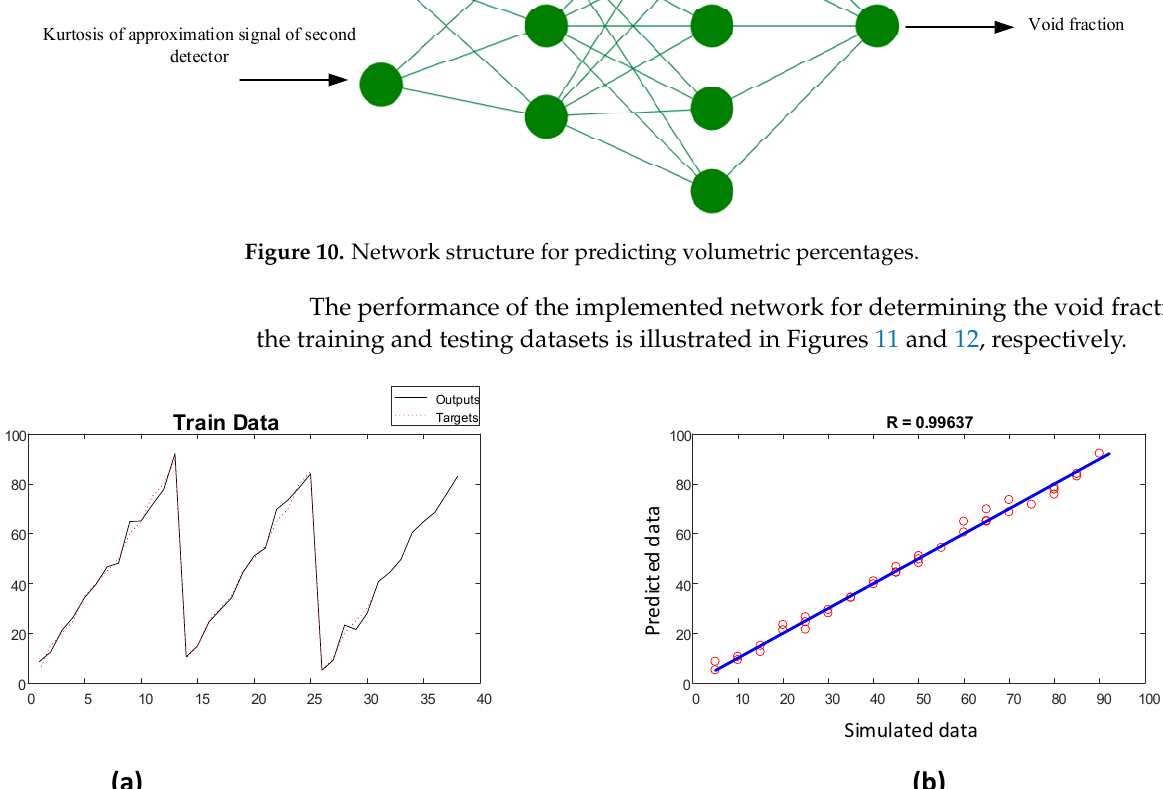
Figure 11. Performance of void fraction estimator network (training): ( a ) fitting diagram and ( b ) regression diagram.